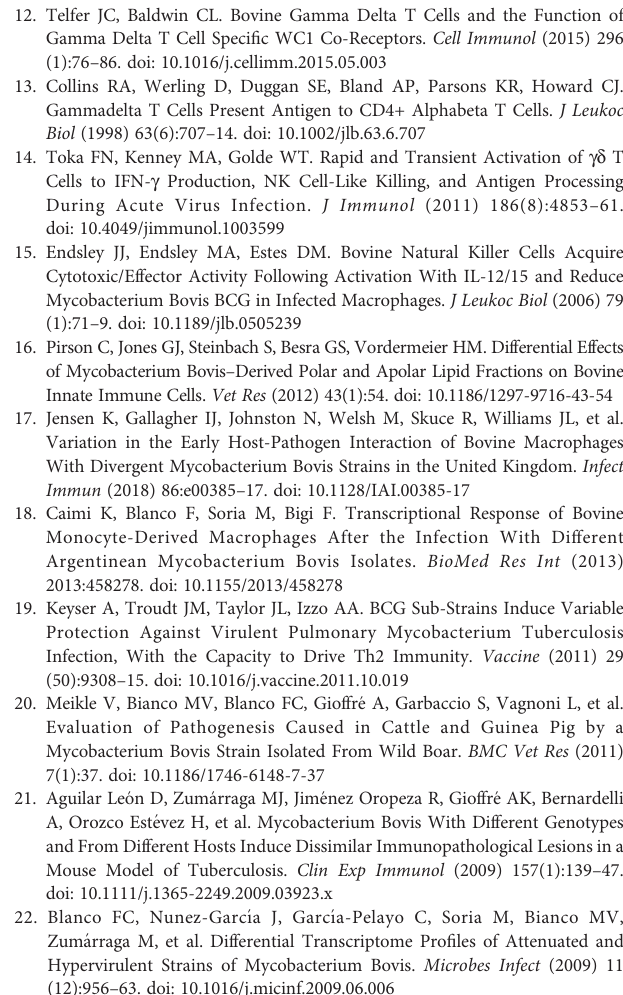
Supplementary Figure 1 | Representative fl ow cytometry using an anti-bovine CD14 antibody (MM61A, VMRD) for evaluation of macrophage purity in cultured adherent cells after 4-5 days of incubation. Supplementary Figure 2 | Representative dot plots. Gate strategy: (1) R1, lymphocyte gate used for WC1+ cells and (2) R2, gate used for NKp46+ cells. Dot plots from representative samples of WC1+IFN- g + in line A and NKp46+ IFN- g + in line B for non-infected and infected co-cultures (double positive events are represented in the upper right quadrant of each dot plot). Representative dot plots of NKp46+IFN- g + cells incubated with 5mg and 10mg lyophilized bacterial culture medium supernatant (CS) from Mb04-303 are depicted in line C.